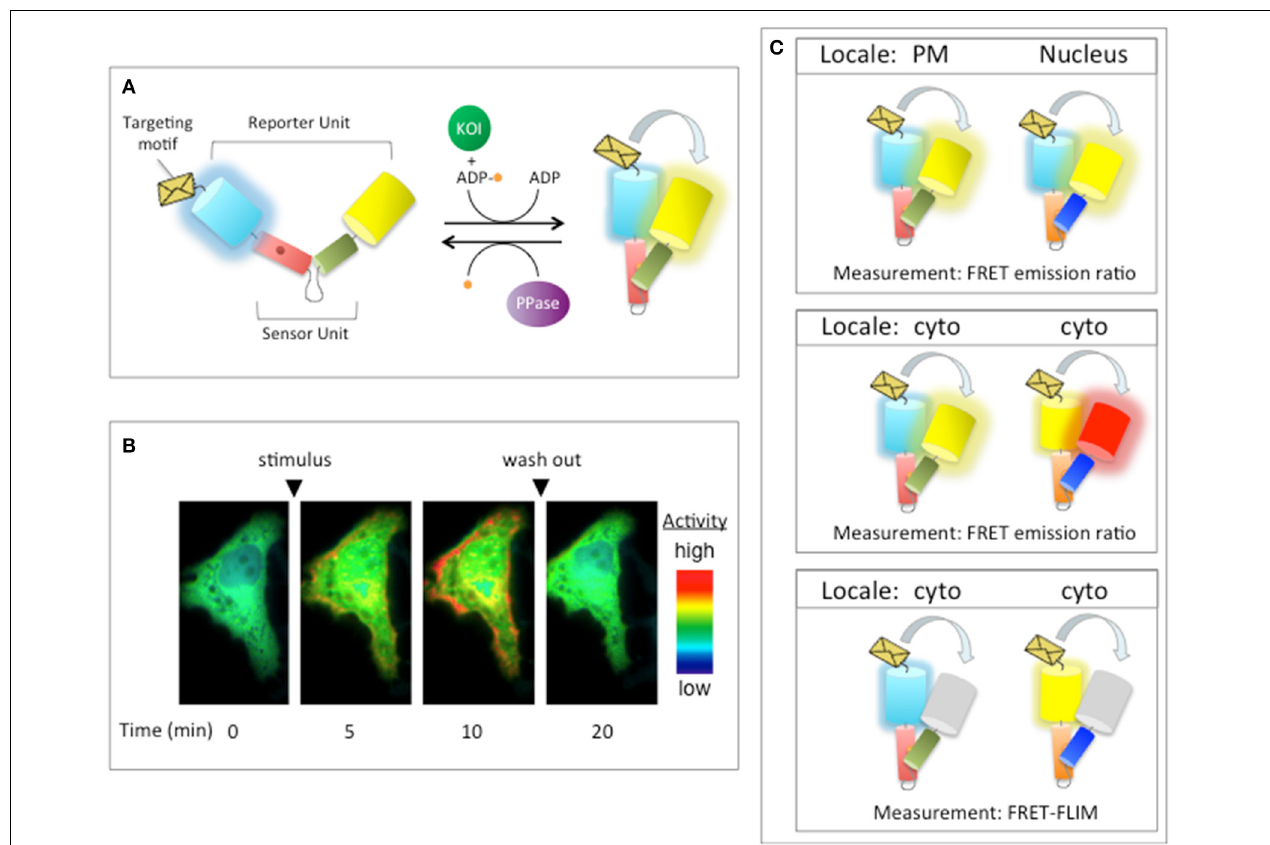
FIGURE 4 | Genetically-targetable FRET-based biosensors. (A) Design of a FRET-based kinase activity reporter based on an engineered molecular switch. In this design, the sensor unit is composed of a PAABD (red cylinder) tethered to a substrate domain (green cylinder) that is specifically phosphorylated by the kinase-of-interest (KOI; green circle). The sensor unit is sandwiched between the reporter unit, which is comprised of two FPs that are able to undergo FRET [e.g., CFP (cyan cylinder) and YFP (yellow cylinder)]. A targeting motif (orange envelope) is used to direct the reporter to distinct subcellular regions. In the unphosphorylated state, the FPs are far removed from one another and, therefore, do not undergo FRET. An increase in the activity of the KOI leads to a phosphorylation-dependent conformational change that alters the distance and/or orientation of the FPs, increasing FRET between them. Phosphatase (PPase; purple oval)-mediated dephosphorylation of the reporter switches it back to the open